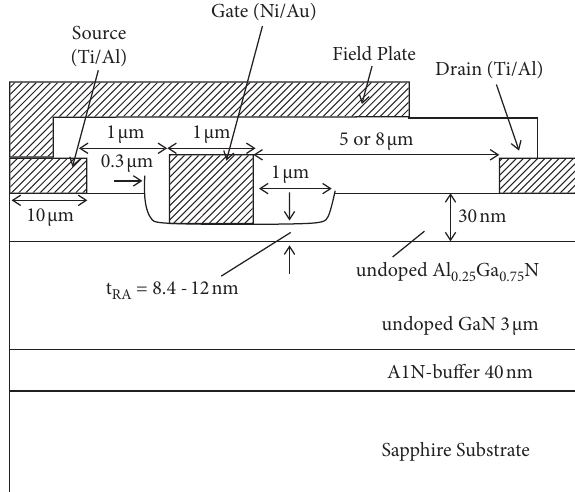
Figure 7: Recessed-gate Ga-N HEMT structure.